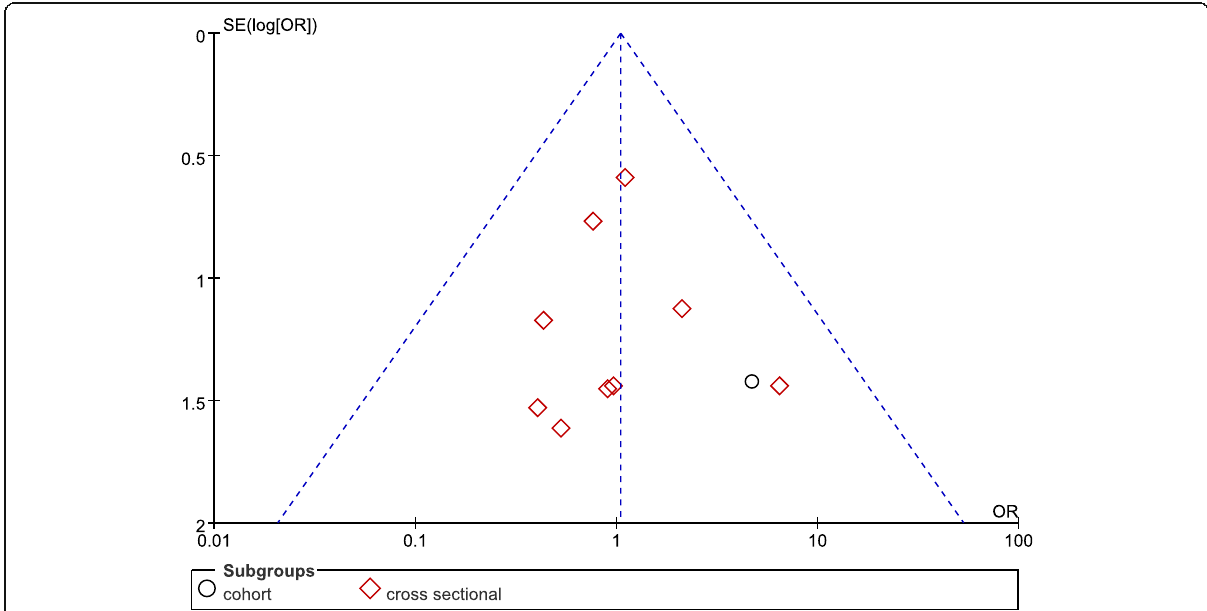
Fig. 6 Funnel plot for the 1-year survival rate between short implants combined with TSFE (experimental group) and conventional implants combined with TSFE (control